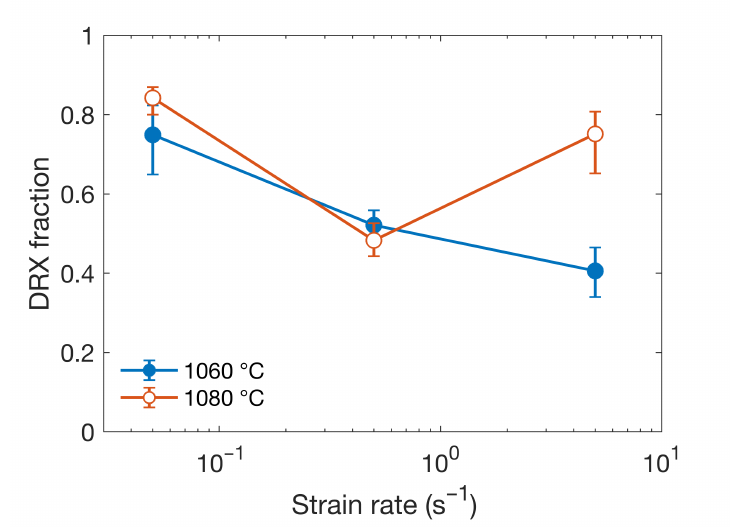
Figure 8. DRX fraction for each strain